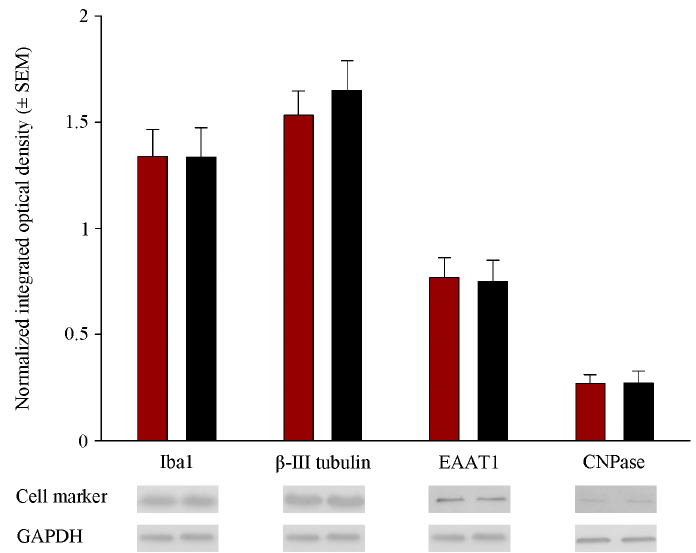
Figure 4. Quantitative Western blot analyses of the main cell types from control and RST-treated newborn rat brains. Controls (red column) and RST-treated (black column) samples were analyzed quantitatively on Western blots for microglial, neuronal, astrocyte, and oligodendrocyte markers. Protein samples (15–30 µg) were separated by gel electrophoresis, transferred to nitrocellulose membranes, and assayed for reactivity toward the Iba1 (microglia marker), beta III tubulin (neuron-specific marker), EAAT1 (astrocyte marker), CNPase (oligodendrocyte marker), and GAPDH proteins. Error bars indicate integrated optical density values (means ± SEM from at least 5 separate experiments) normalized to the values of the internal standard GAPDH. Representative Western blot pictures are shown below the graphs. No statistically significant differences were found between the control and the RST-treated groups.